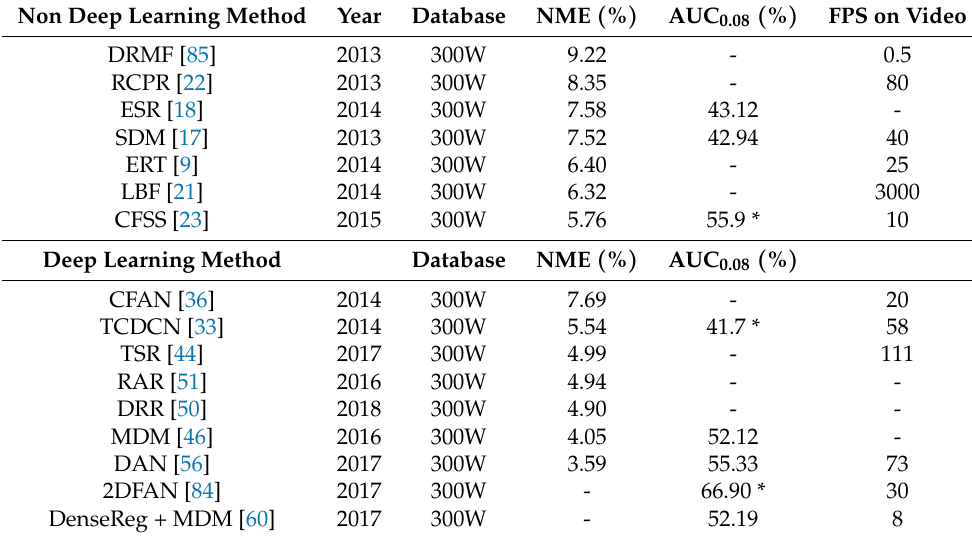
Table 1. Performance comparison of different landmark extraction methods based on NME, AUC, and FPS (frames per second). The upper part of the table lists non-deep-learning methods, while the lower part lists deep-learning methods. Data was obtained from [33,56] and the original publications (*). The measure from [84] was obtained using a threshold of 0.07 on the 300W-private dataset.